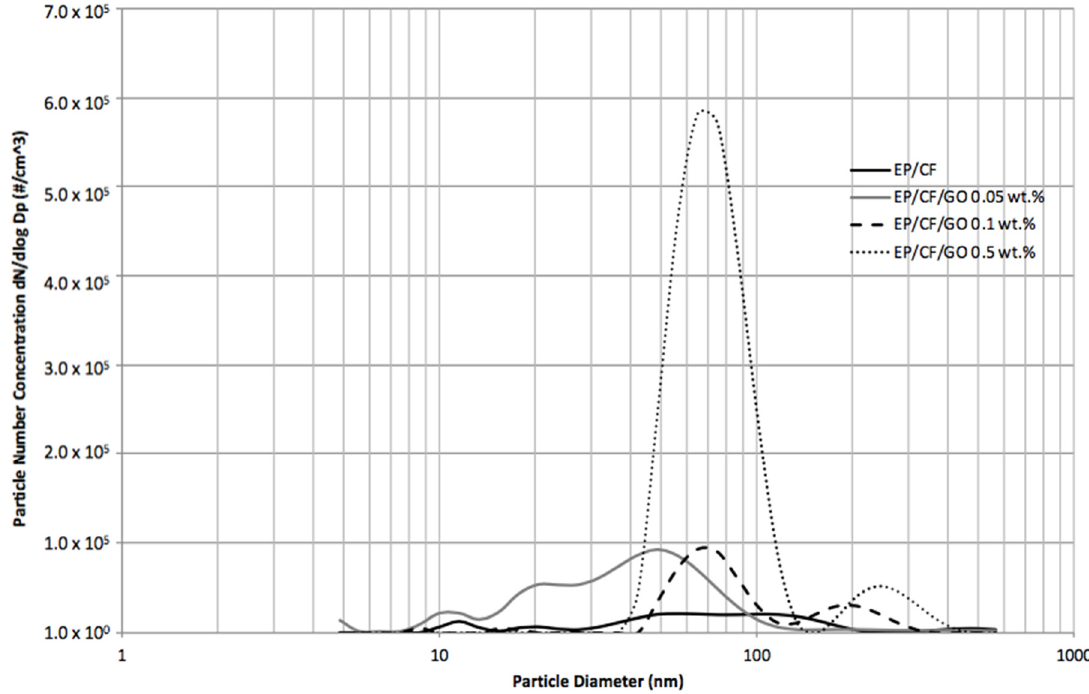
Figure 7. Peak particle size distribution within the 4 minutes sampling of the EP/CF-based samples reinforced with GO recorded on DMS50.